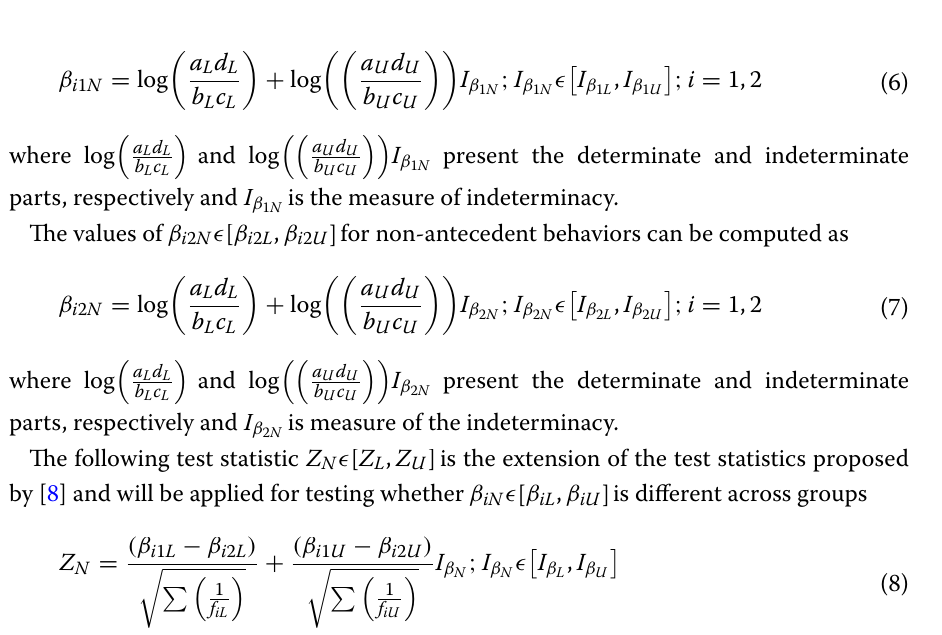
Table 2 The spouse’s behavior data [8] Financial distress Not in financial